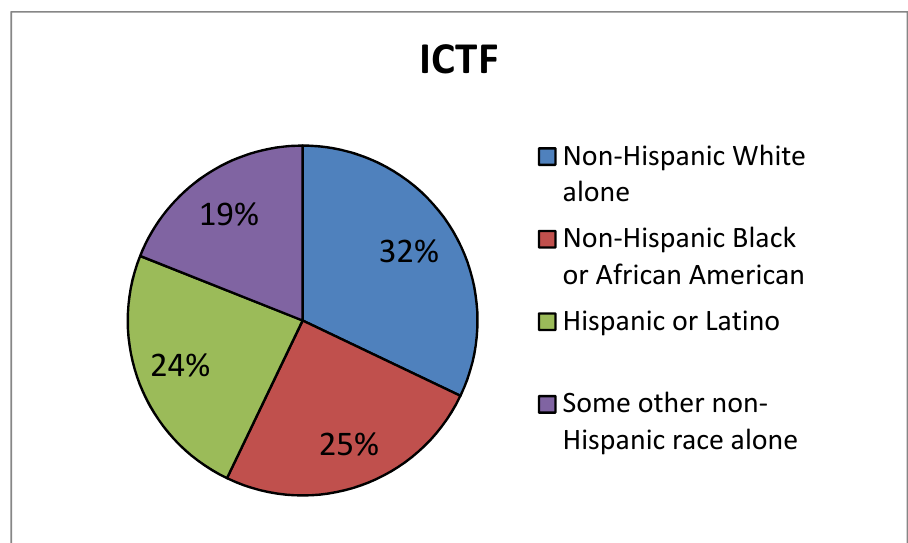
Figure 6. Demographics of the population in west Long Beach in close proximity to the ICTF rail yard, 1980 Census data a,b